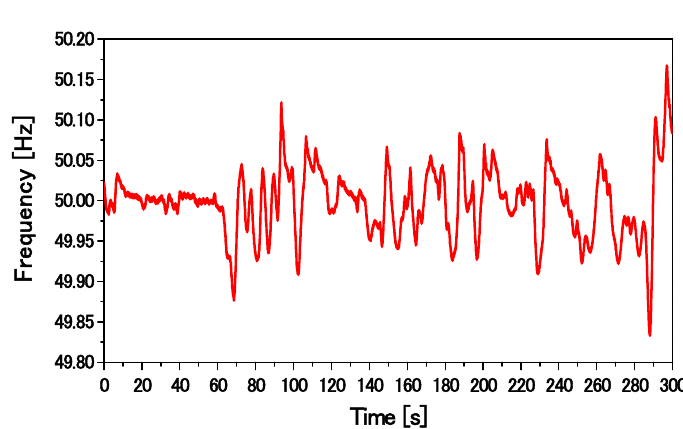
Figure 40. Power system frequency response.